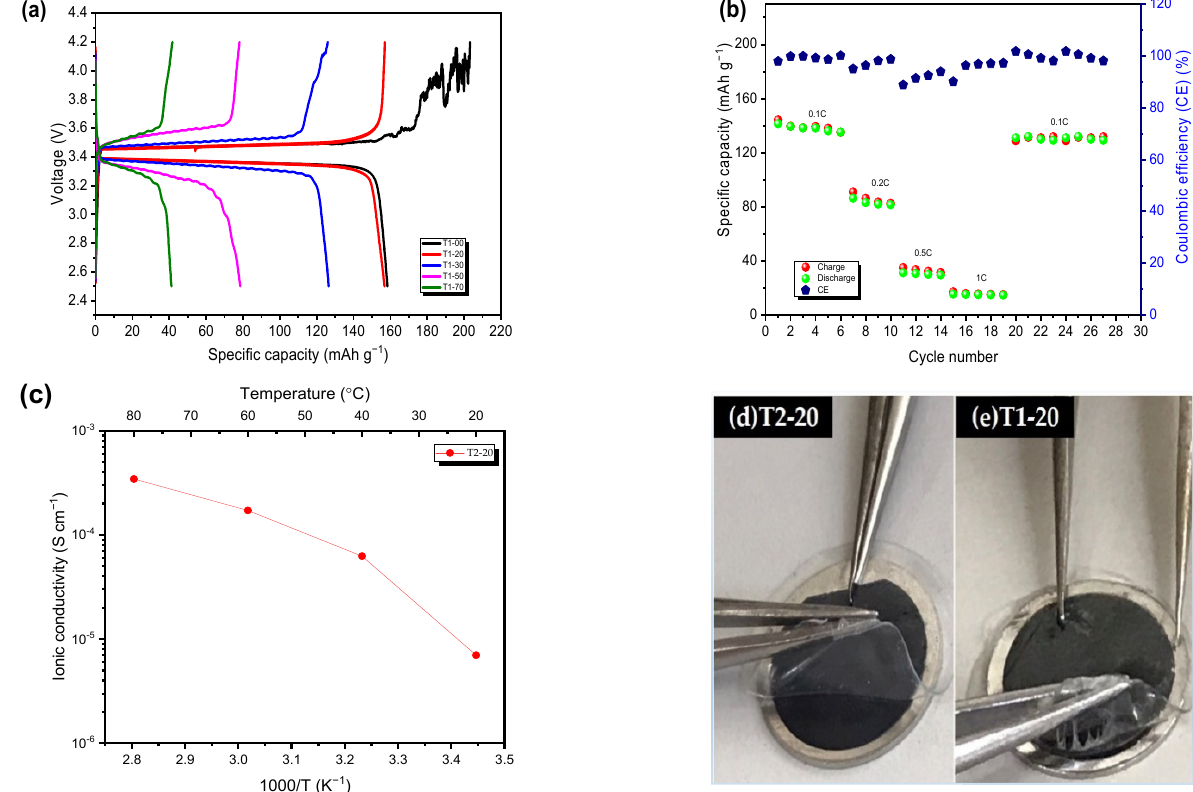
Figure 8. ( a ) The charge − discharge profiles using T1-00, T1-20, T1-30, T1-50, and T1-70 as SPE at 80 ◦ C (0.05 C). ( b ) The specific capacity and the Coulombic efficiency at different C rates in cycle tests for Li°|T1-20|LFP cells at 80 °C. ( c ) Temperature-dependent ionic conductivities of T2-20 and the photos of ( d ) adhesion between T2-20 and cathode, ( e ) adhesion between T1-20 and cathode.